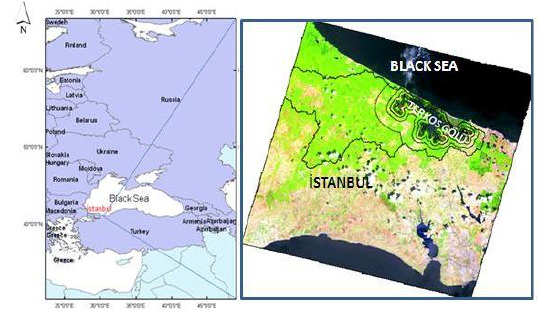
Figure 1. Location of İstanbul and Terkos Water